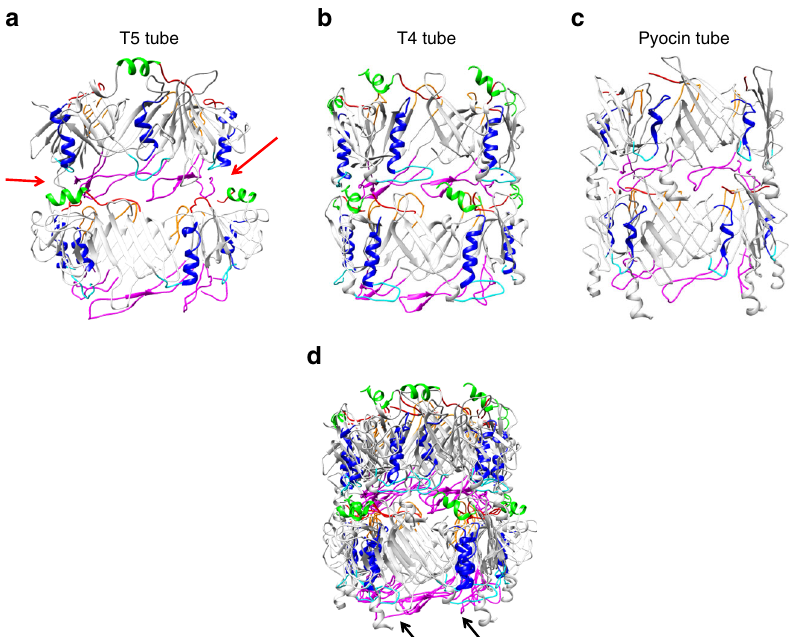
Fig. 4 Comparison of known tube structures. Side views of a stack of two TTP rings are shown, as a ribbon representation. a T5 tail tube pseudo-atomic model. pb6 Ig-like domain and its linker were removed for clarity. b Structure of the T4 tail tube (PDB 5IV5). c Structure of R-pyocin tube (PDB 3J9Q). Red arrows point to notches in the T5 tube that could explain tube fl exibility; in T4 and pyocin tubes, additional inter-ring contacts are observed at these positions. d Superimposition of the three tubes, aligned on the lower ring. The longer loops of the two pb6 subdomains (black arrows) and asymmetry of the interface of two subdomains seem to impose a larger twist: T5 ring is not in register with the two other tubes in the upper ring. In a – d , similar structural features are coloured accordingly: the long loop (magenta) and helix (blue) of the common core fold, the N terminus (red) and two smaller loops (cyan and orange) and an additional N-terminal helix